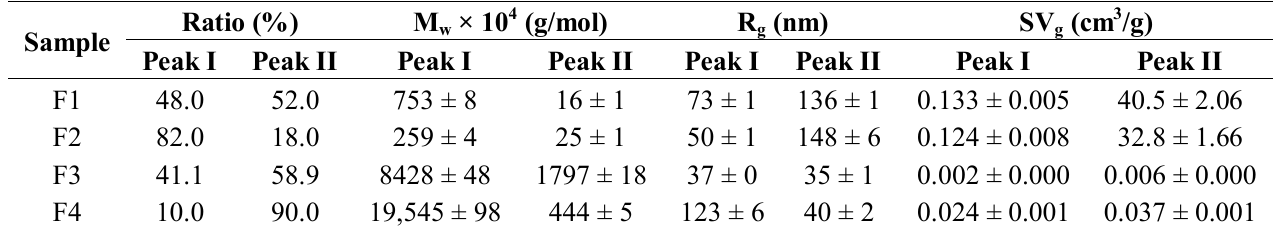
), radius of gyration (R w